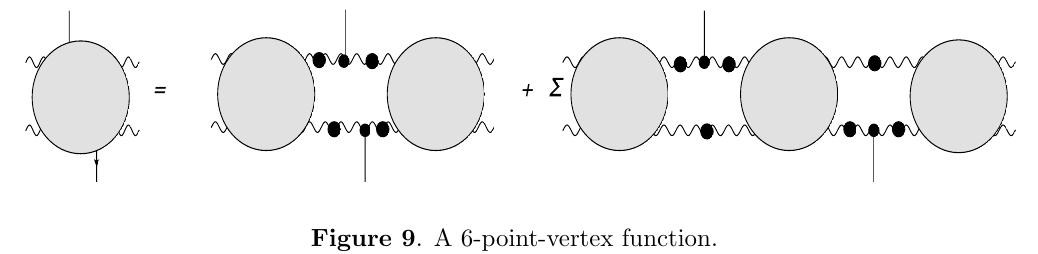
Figure 9 . A 6-point-vertex function.